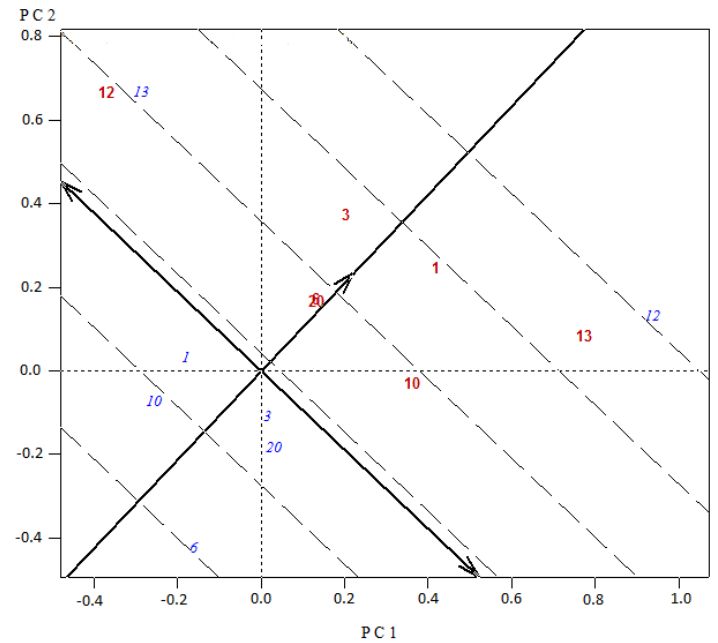
Figure 4. GGE biplot for market yield in Set 2. PC1 and PC 2 accounted for 63% and 26% of the variation, respectively. See codes in Table 1.